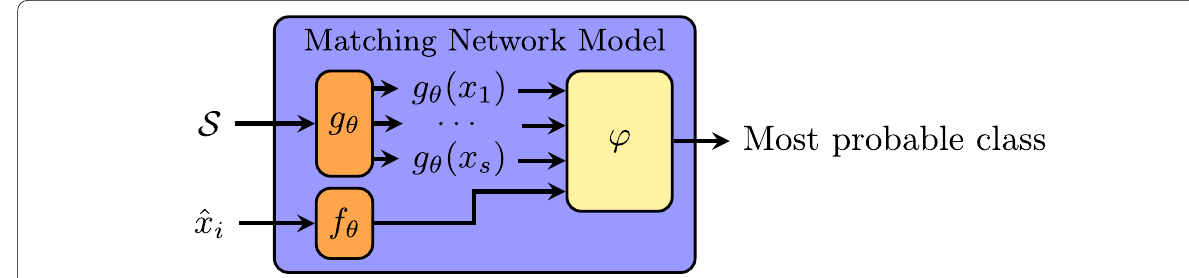
Fig. 3 Illustration of the matching network model to predict the class of a new example ˆ x